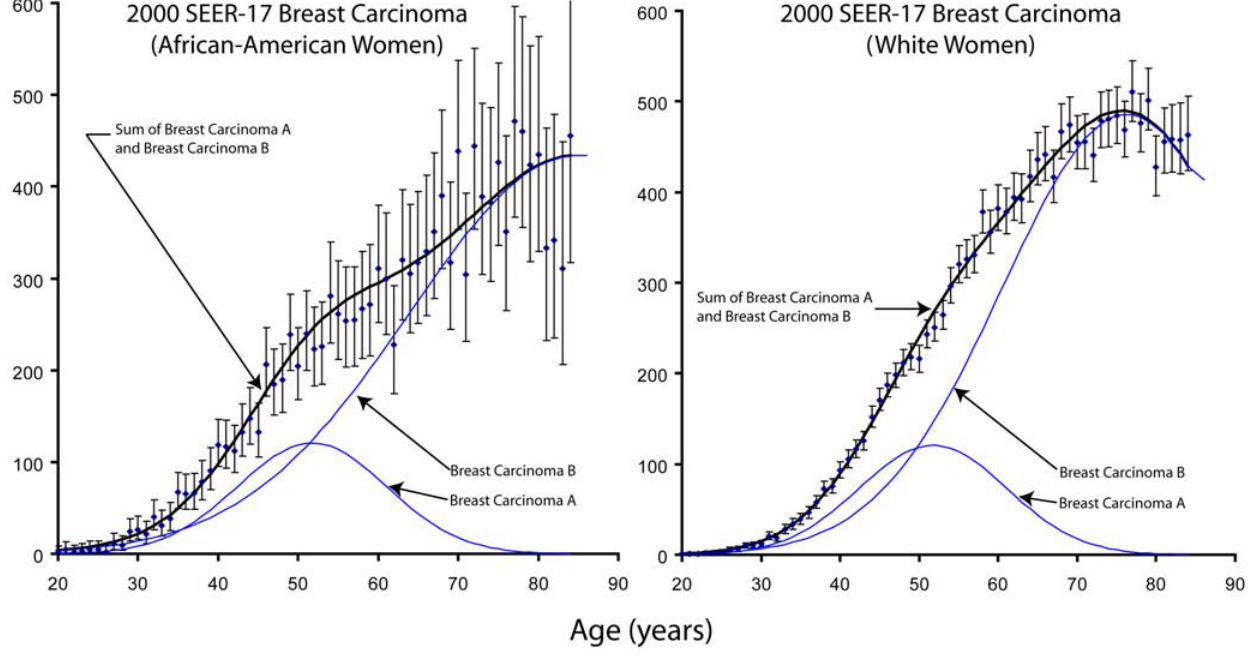
Figure 4. The breast carcinoma disparity between African-American and white women is not due to breast carcinoma A, which occurs at exactly the same rate, but solely due to a difference in breast carcinoma B. The data are from the SEER-17 database during the year 2000 [17]. In each case, the measured incidence is represented by a point and the 95% confidence intervals by error bars. The dark solid lines represents predicted incidence levels based upon the hypothesis, Equation 4, which is the sum of breast carcinoma A and breast carcinoma B indicated by the other curves.